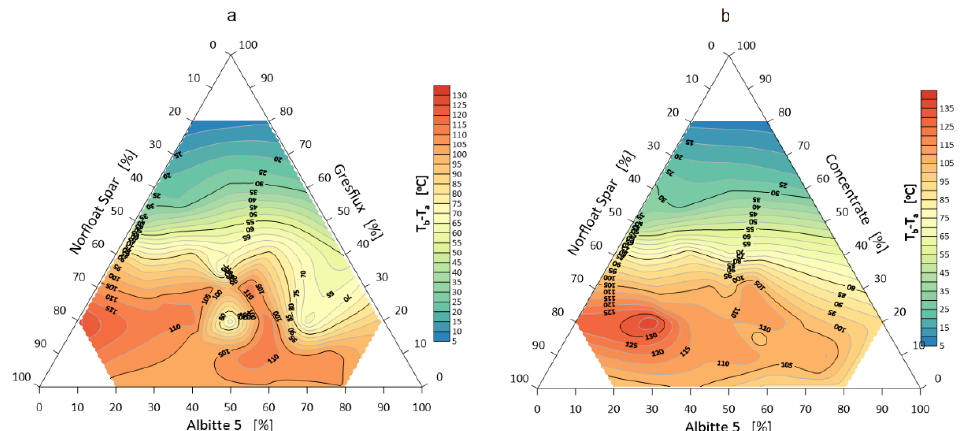
Figure 9. Melting interval of flux system Greflux–Albitte 5–Norfloat Spar ( a ), and Concentrate–Al- bitte 5–Norfloat Spar ( b ).